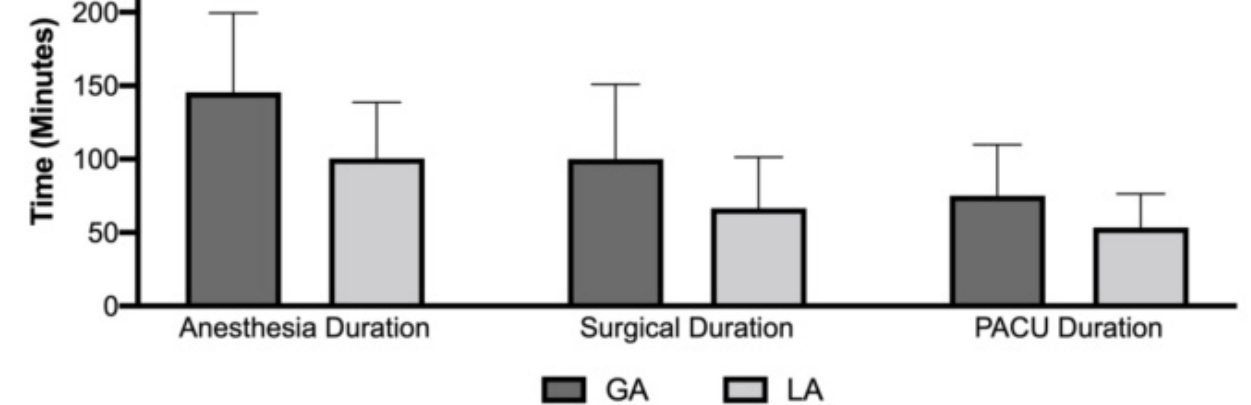
Figure 3. Graph comparing the anesthesia and surgery duration under general anesthesia (GA) compared to local anesthesia (LA). The anesthesia duration and the surgery duration were significantly higher in the GA group.